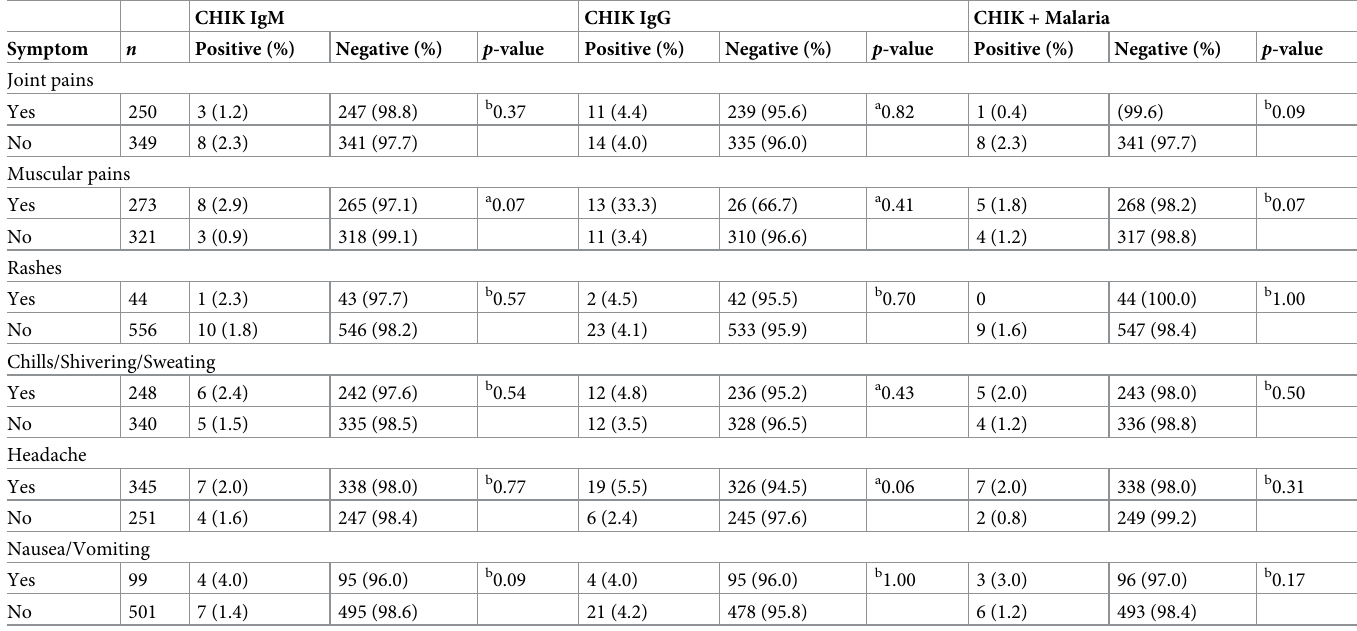
Table 2. Association of symptoms with chikungunya IgM, IgG, and